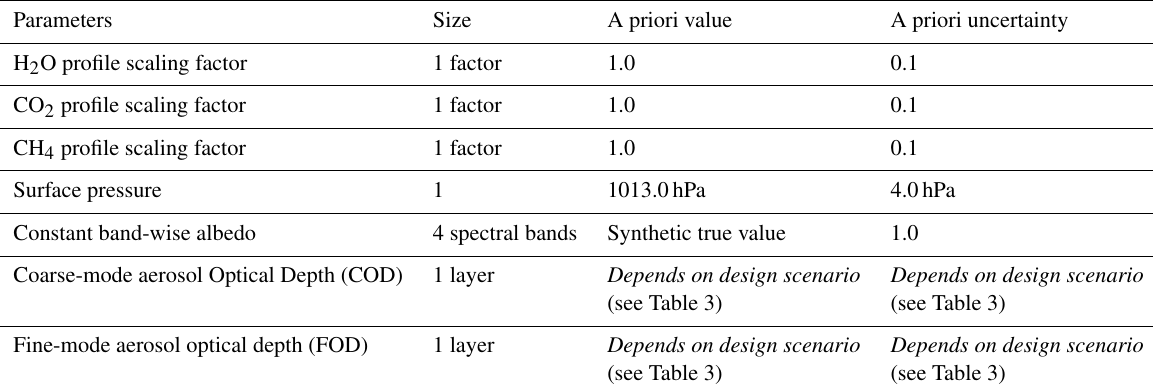
Table 2. 5AI retrieval state